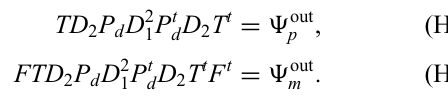
FIG. 10. The simulation of entangled photons propagating through a thick scattering medium. (a) The experimental setup considered in our simulation. The pump beam has a wavelength of 405 nm and a beam diameter of 5 mm. The focal length is f = 500 mm and the propagation distance d = 200 mm. The nonlinear crystal is considered to be infinitely thin. (b) The minus-coordinate projection measured in the position-basis con- figuration and (c) the sum-coordinate projection measured in the momentum-basis configuration after optimization using SLM1. (d) The minus-coordinate projection measured in the position- basis configuration and (e) the sum-coordinate projection mea- sured in the momentum-basis configuration after optimization using SLM1 and SLM2. SM, scattering medium; SLM, spatial light modulator; BBO, β -barium